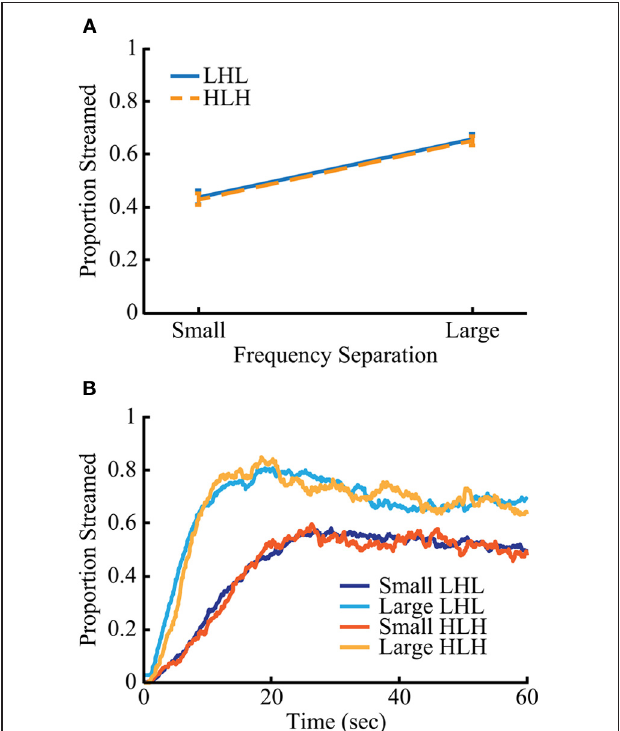
FIGURE 2 | Behavior for the two sequence types is nearly identical. Streaming rates (A) and buildup (B) are nearly identical between the two sequence types ( low-high-low and high-low-high ) but differ significantly between frequency separation ( small and large ) ( p < 0 . 005). Error bars in (A) represent